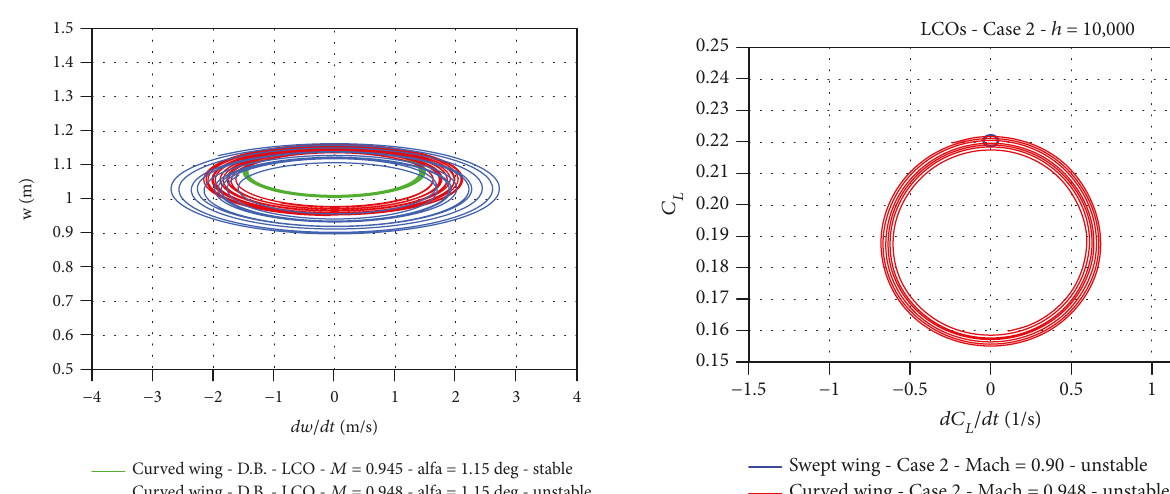
Figure 30: FSI analyses of the swept wing — Case 2 (cruise — tip displacement LCO — DB).